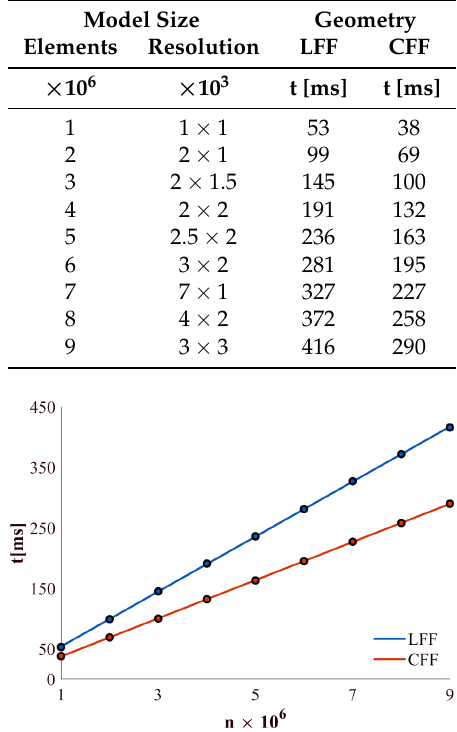
Figure 22. Computational efficiency of the CFF method depending on the model size compared to the LFF